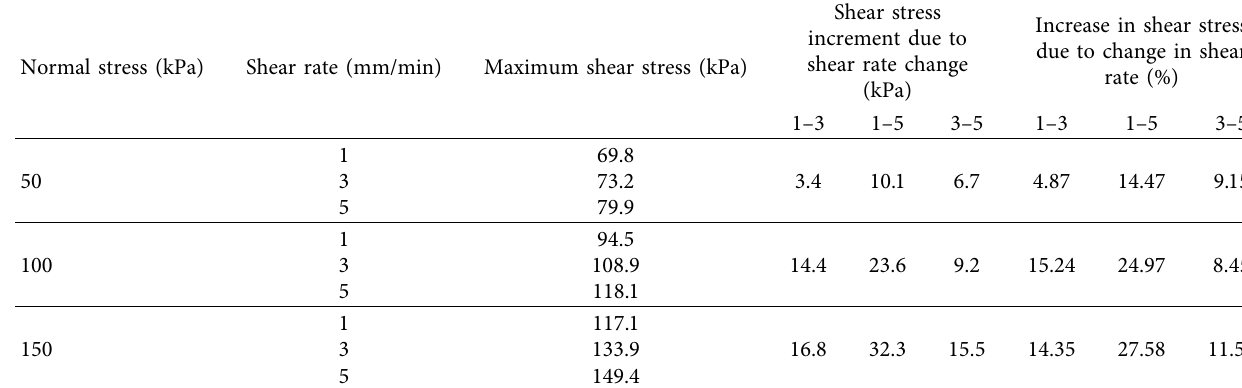
Table 4: Change in shear stress with shear rate.